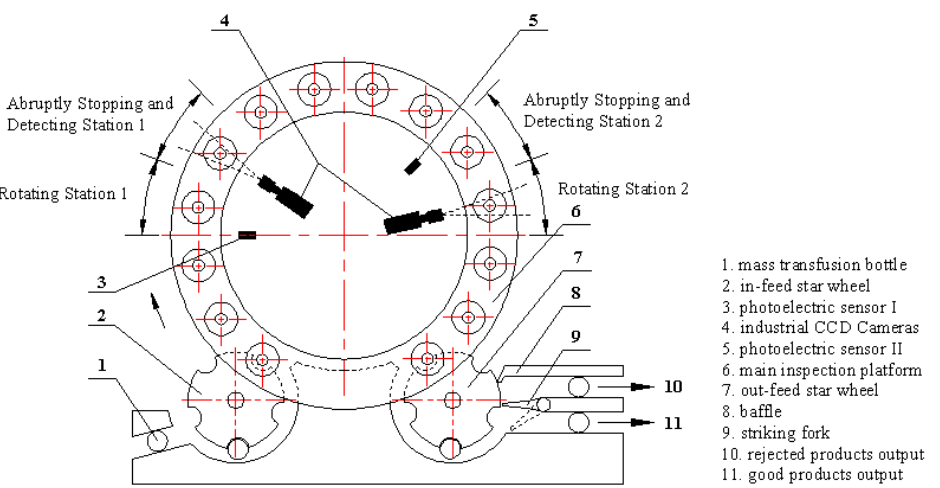
Figure 3. Top view of inspection system’s rotary table architecture.